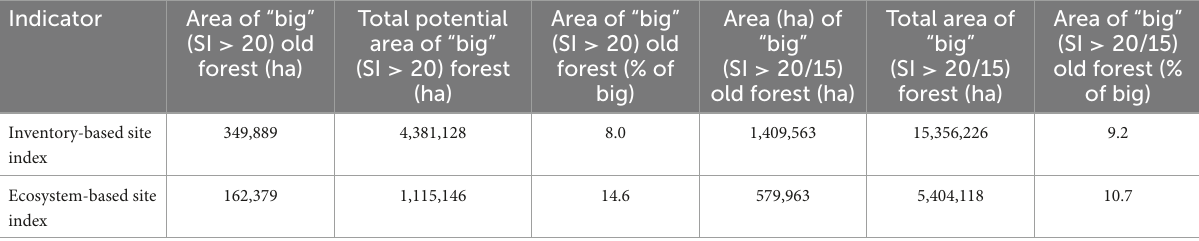
TABLE 4 The proportion of high-productivity forests classified as old growth estimated using two indicators calibrated to improve consistency.